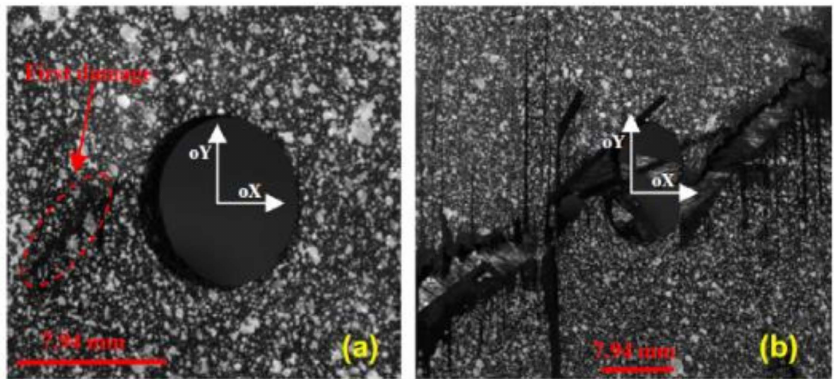
Figure 27. Damage progression for di ff erent loading levels for 7.94 mm drilled hole in OHT test for ( a ) 42.5 kN and ( b ) 49 kN loading